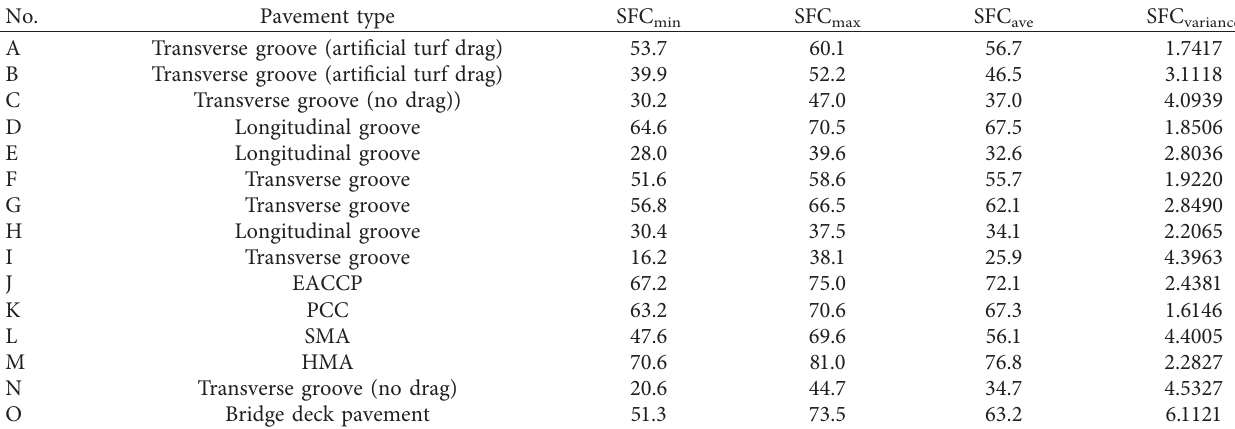
Table 2: Statistical results of pavement skid resistance.